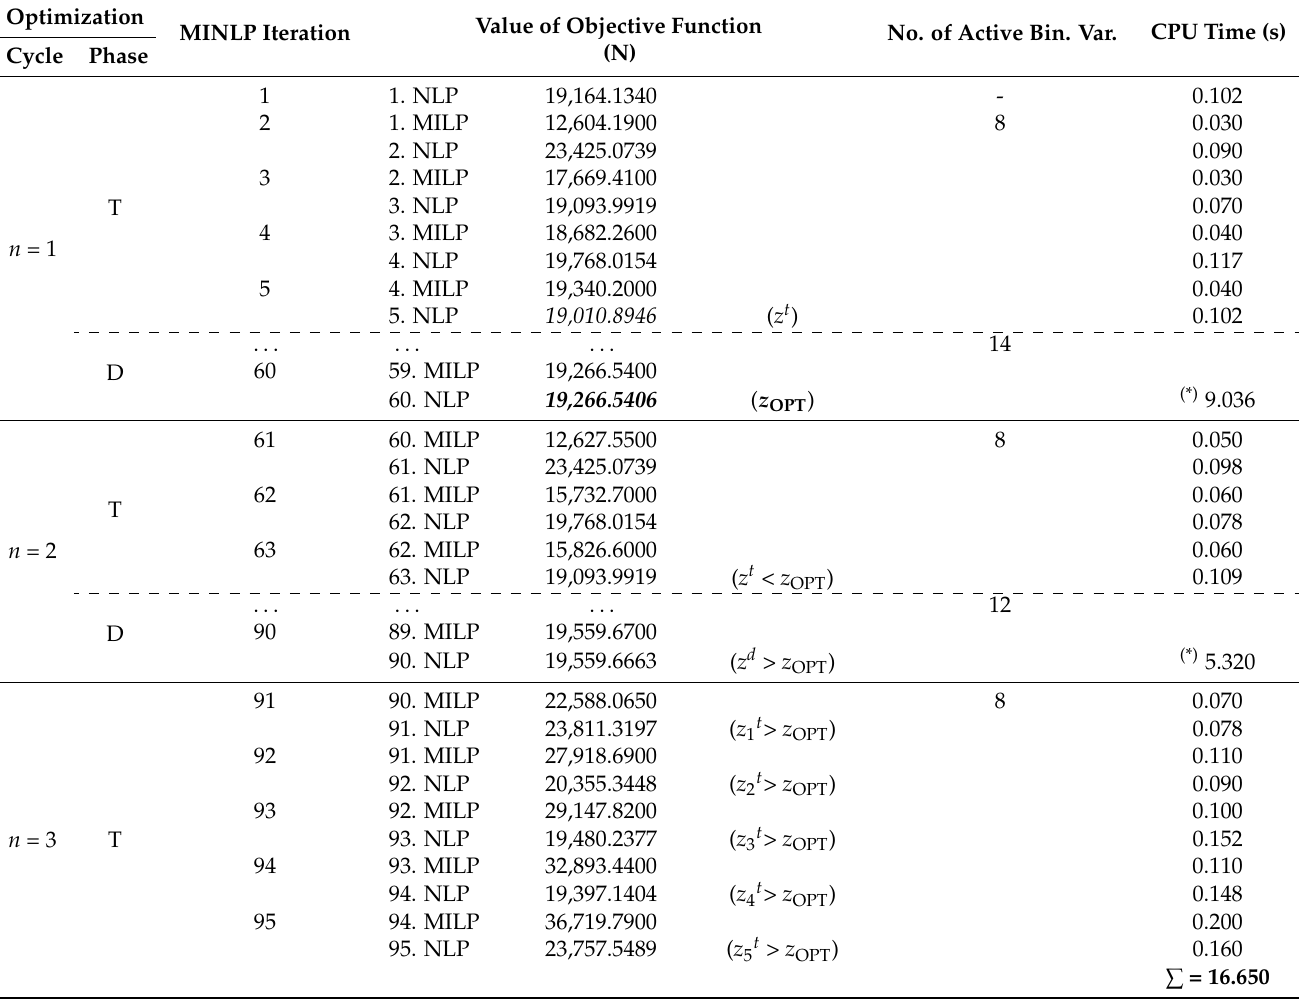
Table 1. Convergence of the Modified OA/ER algorithm and the MTP strategy, example TC10a (topology optimization, without buckling constraints).